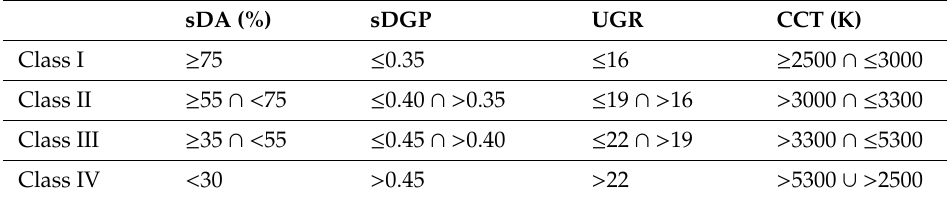
Table 1. Thresholds for each class regarding spatial daylight autonomy (sDA), simplified daylight glare